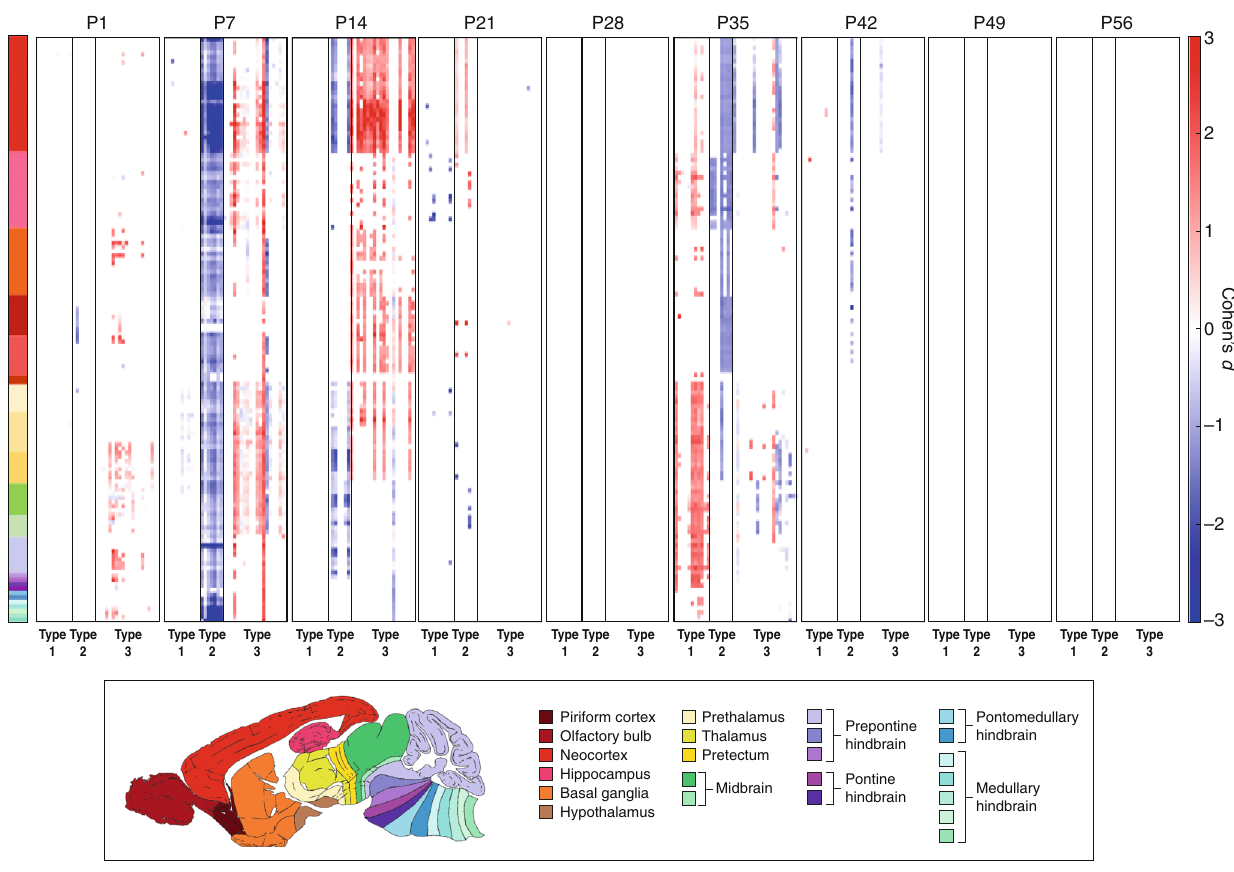
Fig. 2 | Brain synaptome phenotypes during postnatal development of Pax6 +/ − mice. The difference (Cohen ’ s d ) in synapse type and subtype density in 131 brain subregions at nine ages from birth to P56 between Pax6 +/ − and control mice.